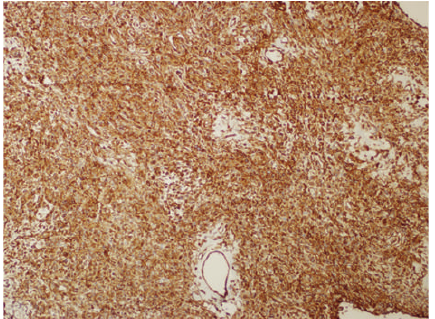
Figure 5: Di ff use CD34 positivity in tumor cells (DAB, × 100).